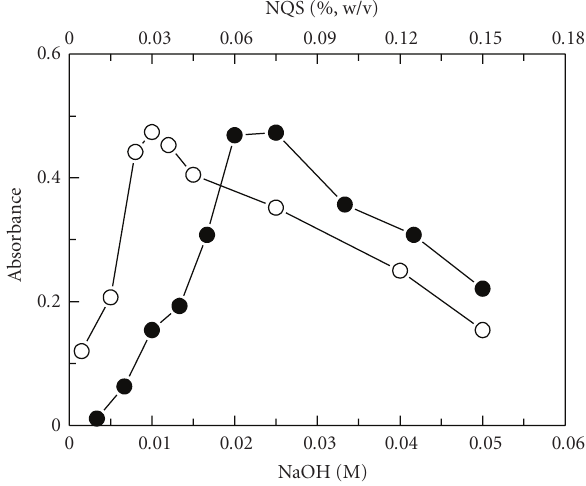
Figure 3: E ff ect of heating temperature ( ◦ ) and time ( • ) on the reaction of AMD (45 μ gmL − 1 ) with